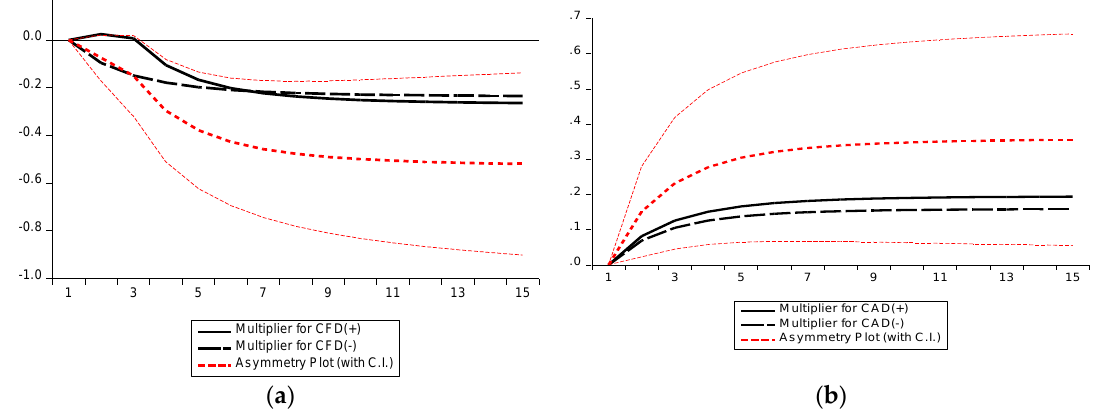
Multiplier for CFD(+) Multiplier for CFD(-) Asymmetry Plot (with C.I.) Figure 11. ( a ) Dynamic Multiplier Graphs for effect of CFD on OP. ( b ) Dynamic Multiplier Graphs for effect of CAD on OP. Source: Authors’ calculation.